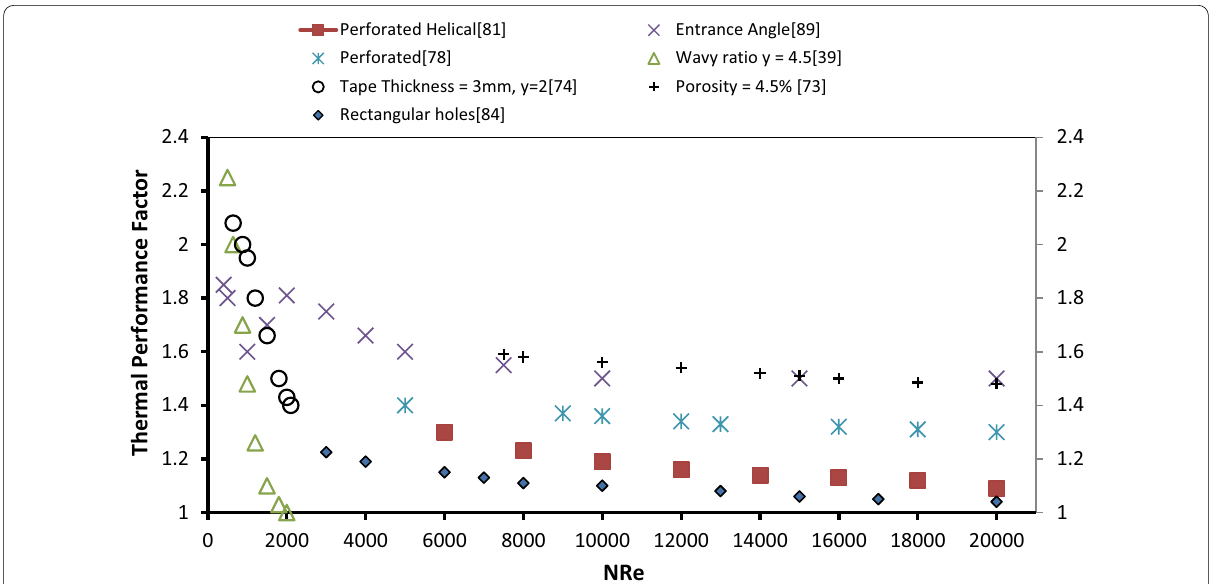
Fig. 9 Comprehensive study of different geometries of twist tape in I—laminar, II—Transitional, III—turbulent